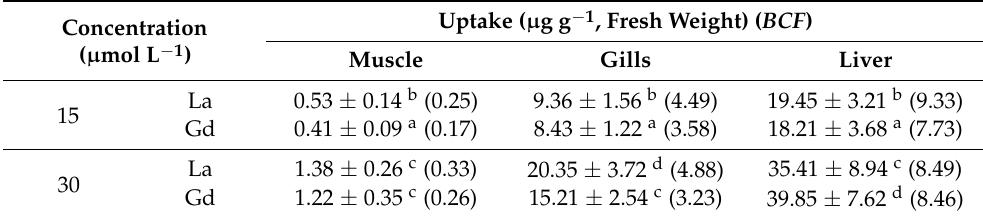
Table 1. La and Gd uptake and bioconcentration factors ( BCF ) in muscle, gills, and liver tissues of Danio rerio exposed to 15 and 30 µ mol L − 1 La and Gd for 28 days, respectively.